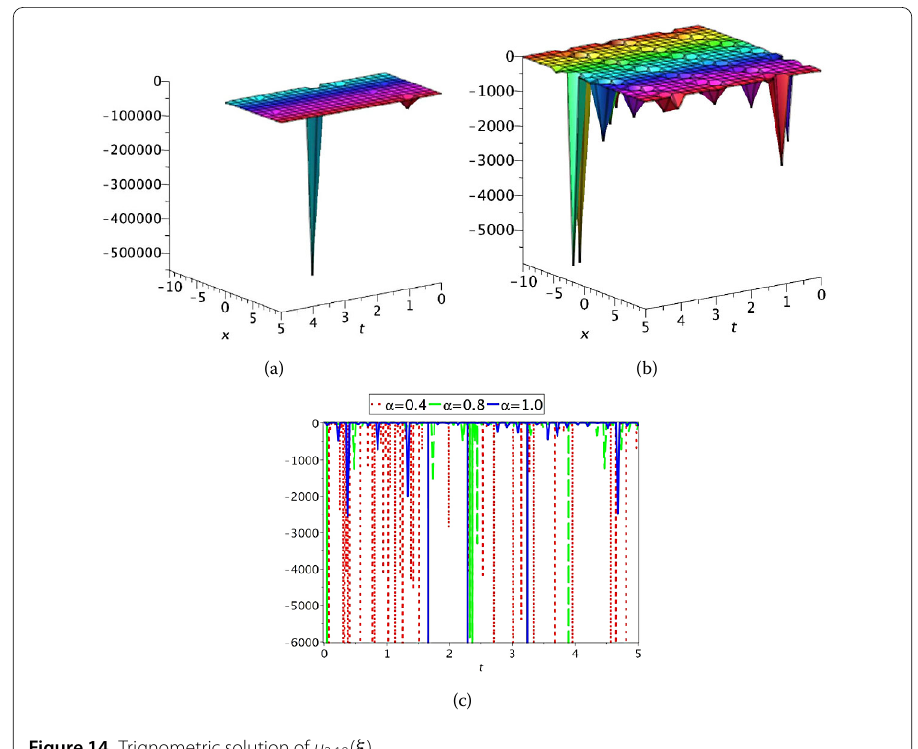
Figure 14 Trignometric solution of u 2,19 ( ξ )